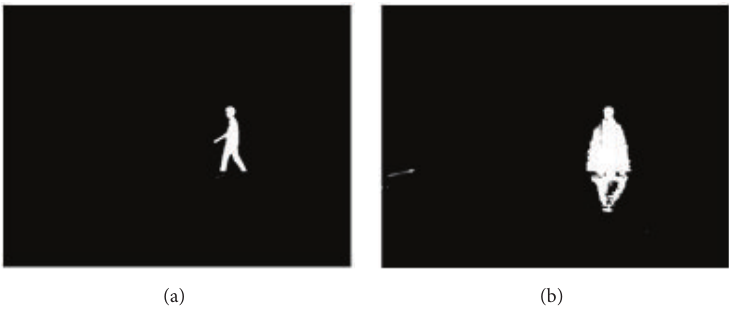
Figure 4: Threshold suppression. (a) Initial segmentation using Otsu threshold. (b) Segmentation by adding parameter 𝑐